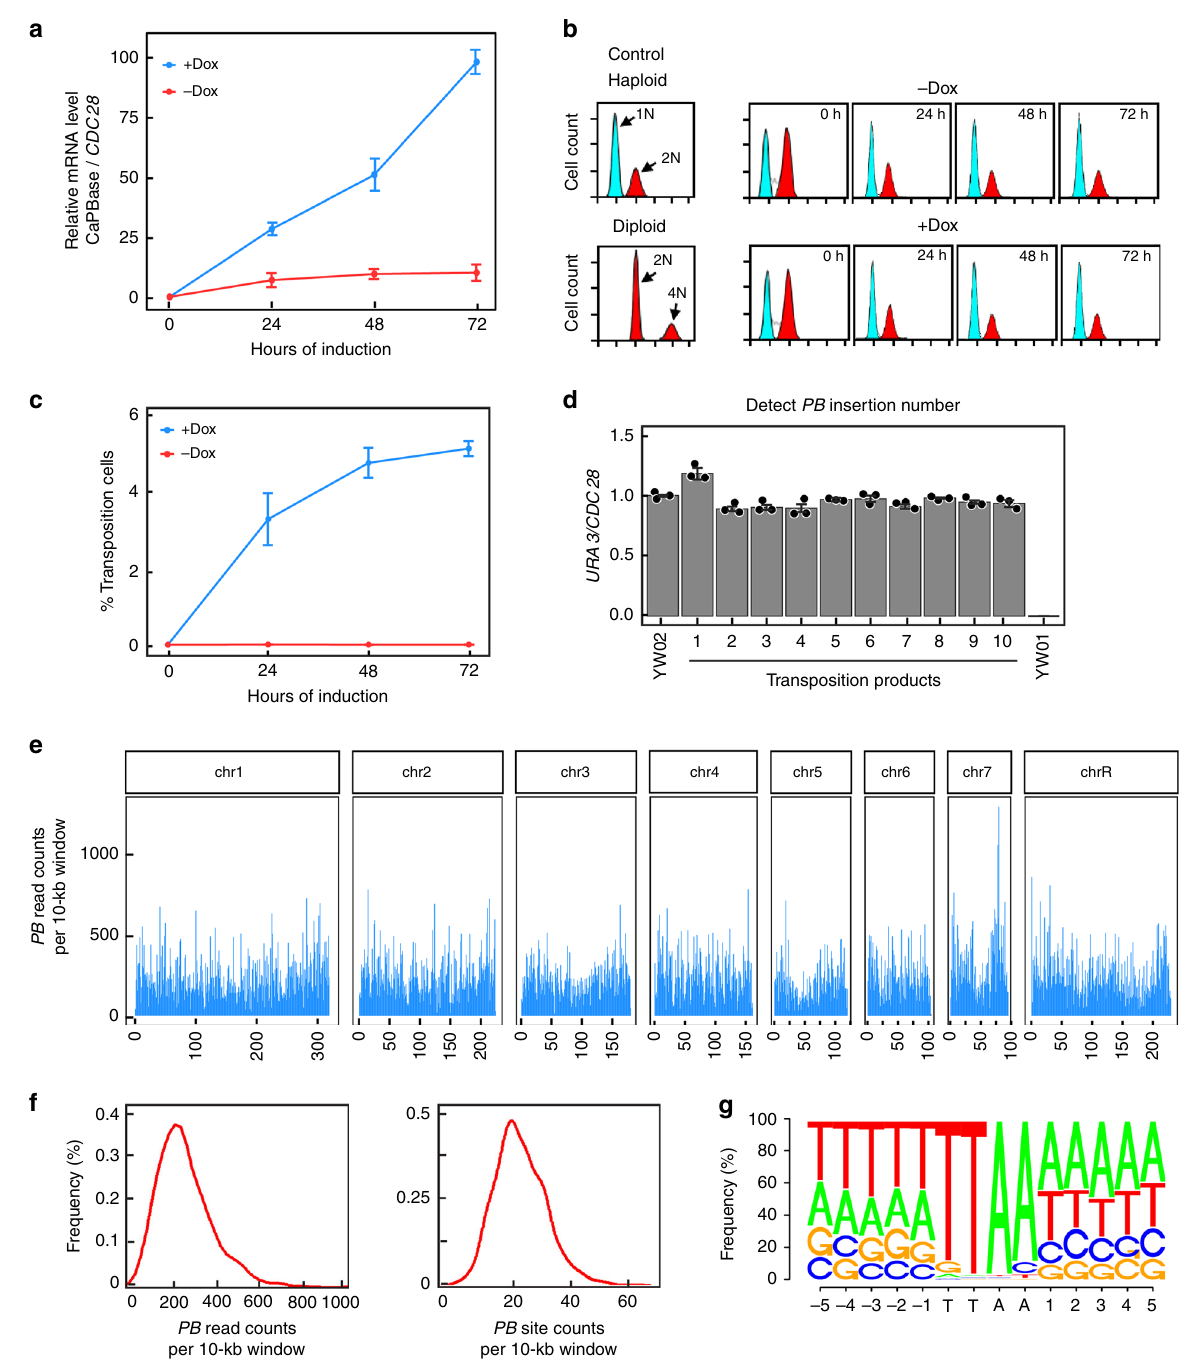
Fig. 2 PB transposition and insert distribution in C. albicans genome. a qPCR analysis of CaPBase expression during transposition induction. CDC28 mRNA level was used for normalization. Error bars represent standard deviation (s.d.) from the mean of triplicate samples. b Ploidy analysis during transposition induction by fl ow cytometry. The DNA content of induced cells at each time point was compared with that of haploid and diploid control strains. c Estimation of transposition ef fi ciency in YW02. See the text for description. Error bars represent s.d. from the mean of three independent experiments. d Analysis of PB copy number in transposition products by comparing the levels of URA3 and CDC28 DNA using qPCR. YW01 and YW02 were included as controls. Error bars represent s.d. from the mean of triplicate samples. e Genome-wide NGS analysis of PB distribution. PB -speci fi c reads were plotted in 10- kb sliding windows. f Histogram of PB -speci fi c read counts and PB -speci fi c site counts per 10-kb window. g Motif analysis of PB -insertion